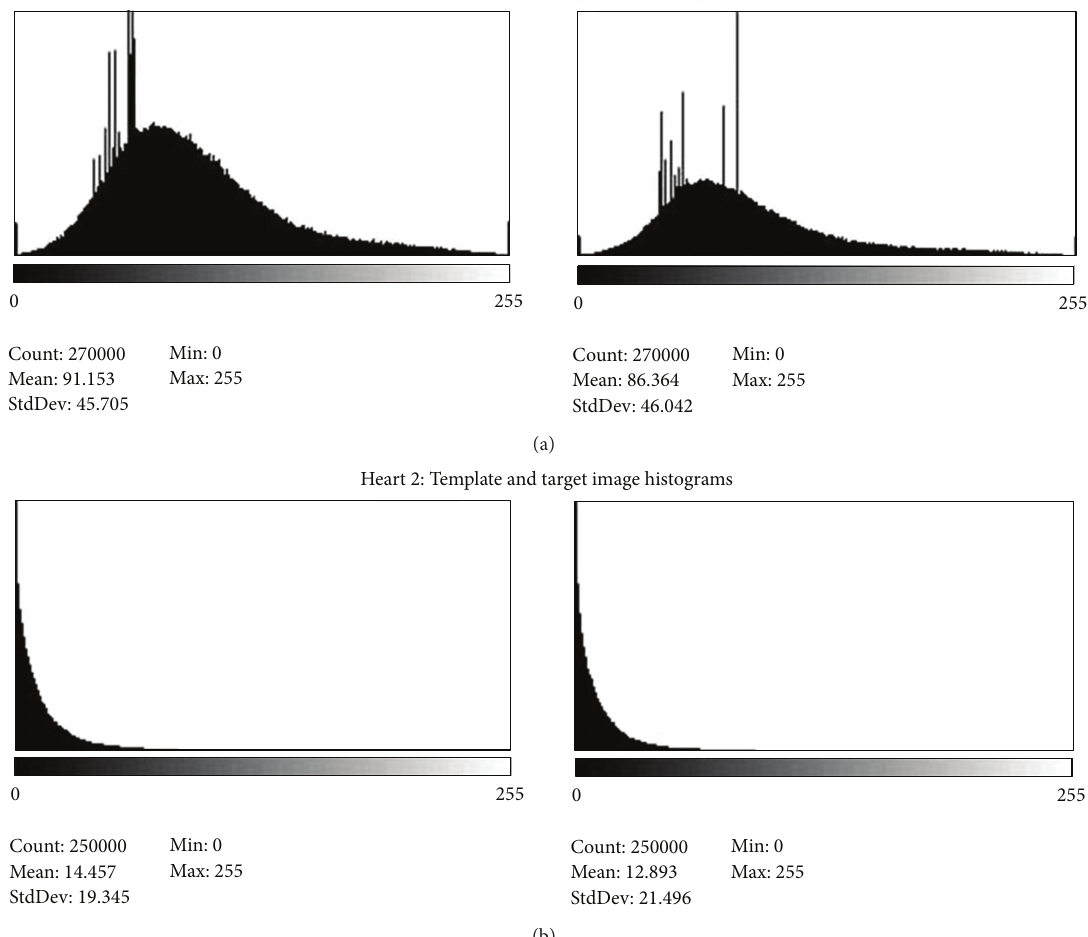
Figure 10: The mean image intensity of the template images in both Heart 1 (a) and Heart 2 (b) had higher mean intensity values than the final target image data